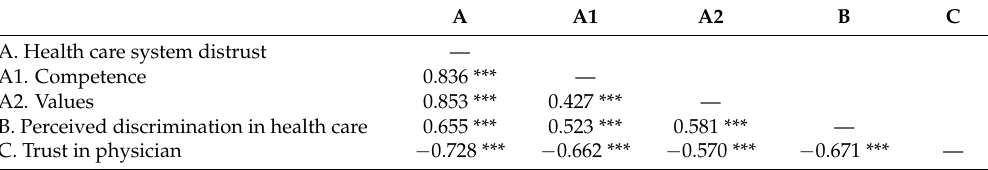
Table 3. Convergent validity of the Health Care System Distrust